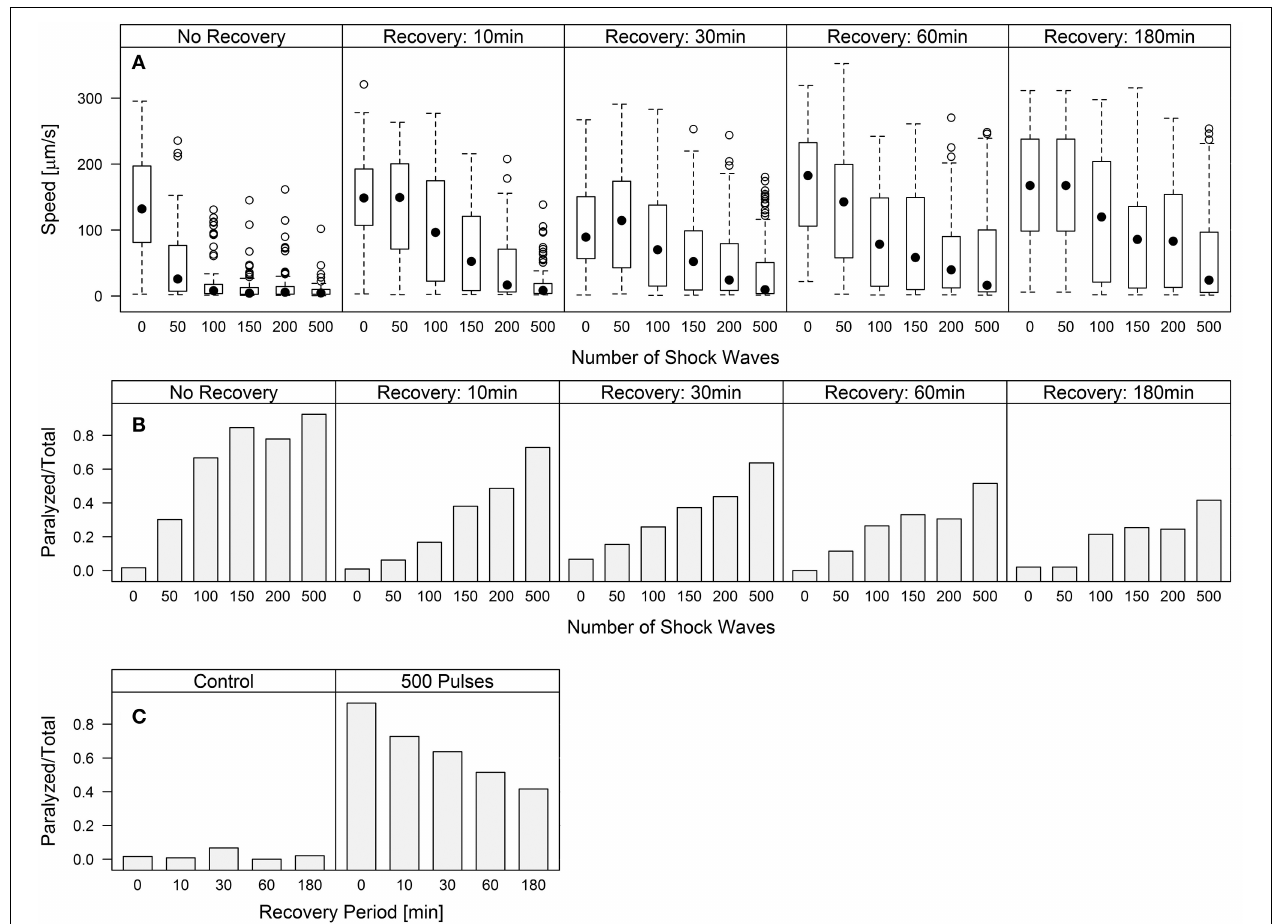
FIGURE 3 | C.elegans regainbehavioralfunctionfollowingtheapplication of shock waves. (A) Increased shock wave exposure reduced average worm speed ( p < 0 . 001), whileincreasedrecovery period of upto180minresulted in increased speed ( p < 0 . 001) (B) Fraction of worms paralyzed decreased over a